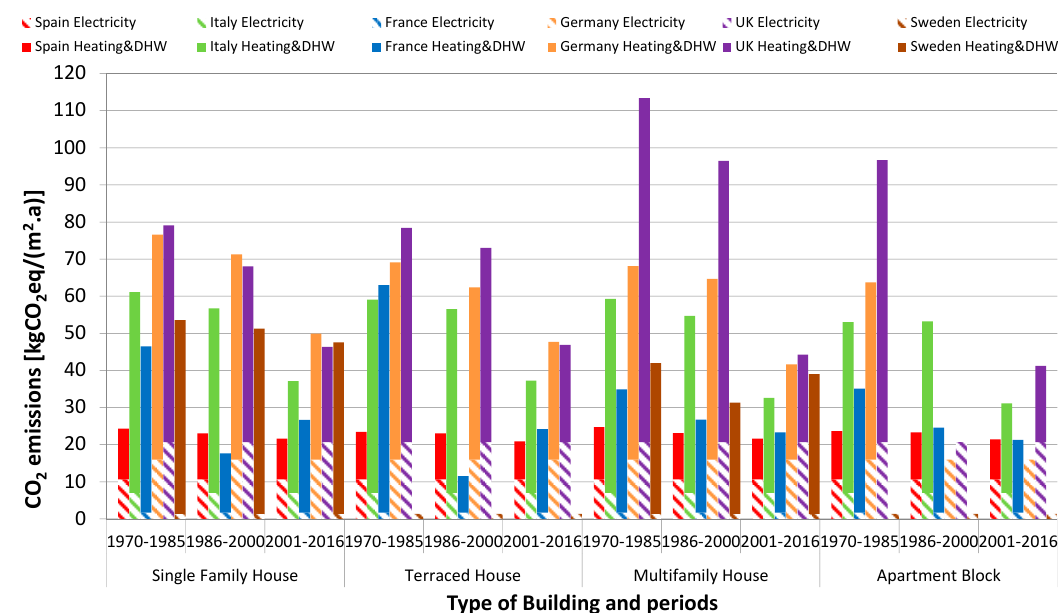
Figure 9. CO 2 emissions of electricity, heating and DHW consumption per square metre in hot climates.